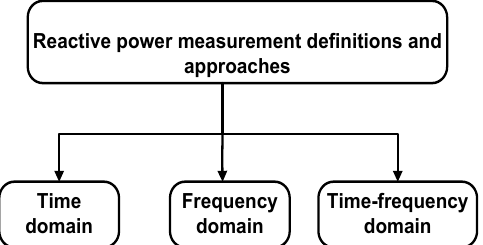
Figure 1. Categories of reactive power measurement definitions and